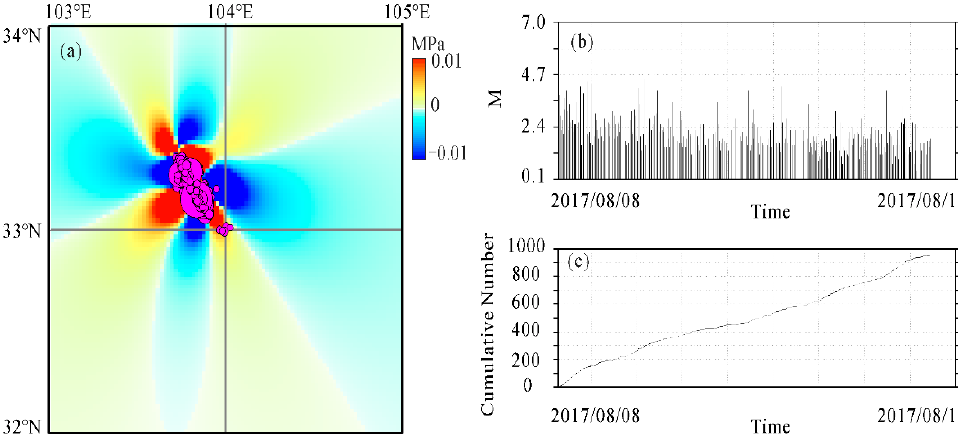
Figure 7. ( a ) Distribution of coseismic Coulomb failure stress changes caused by the 2017 Ms 7.0 Jiuzhaigou earthquake at the depth of the mainshock and aftershocks (Yi et al. [22]). ( b ) Temporal distribution of aftershock magnitudes. ( c ) Cumulative number of aftershocks over time.